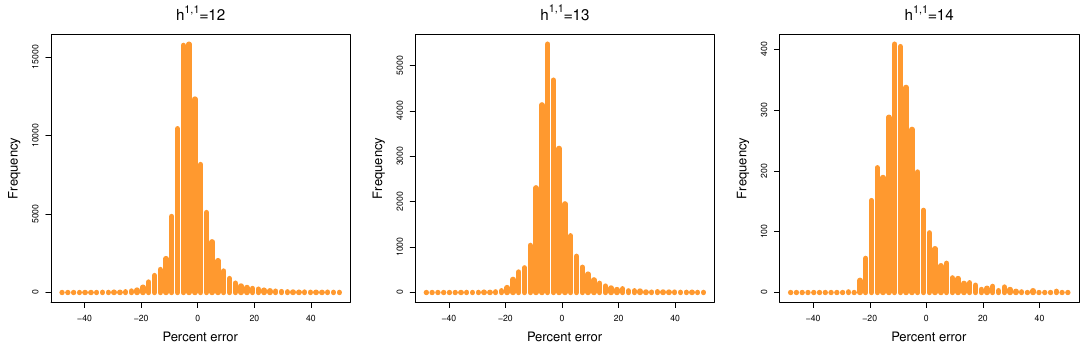
Table 3 . Prediction results for ln( N FRT ), using the traditional neural network, for h 1 ; 1 values outside of its training region.